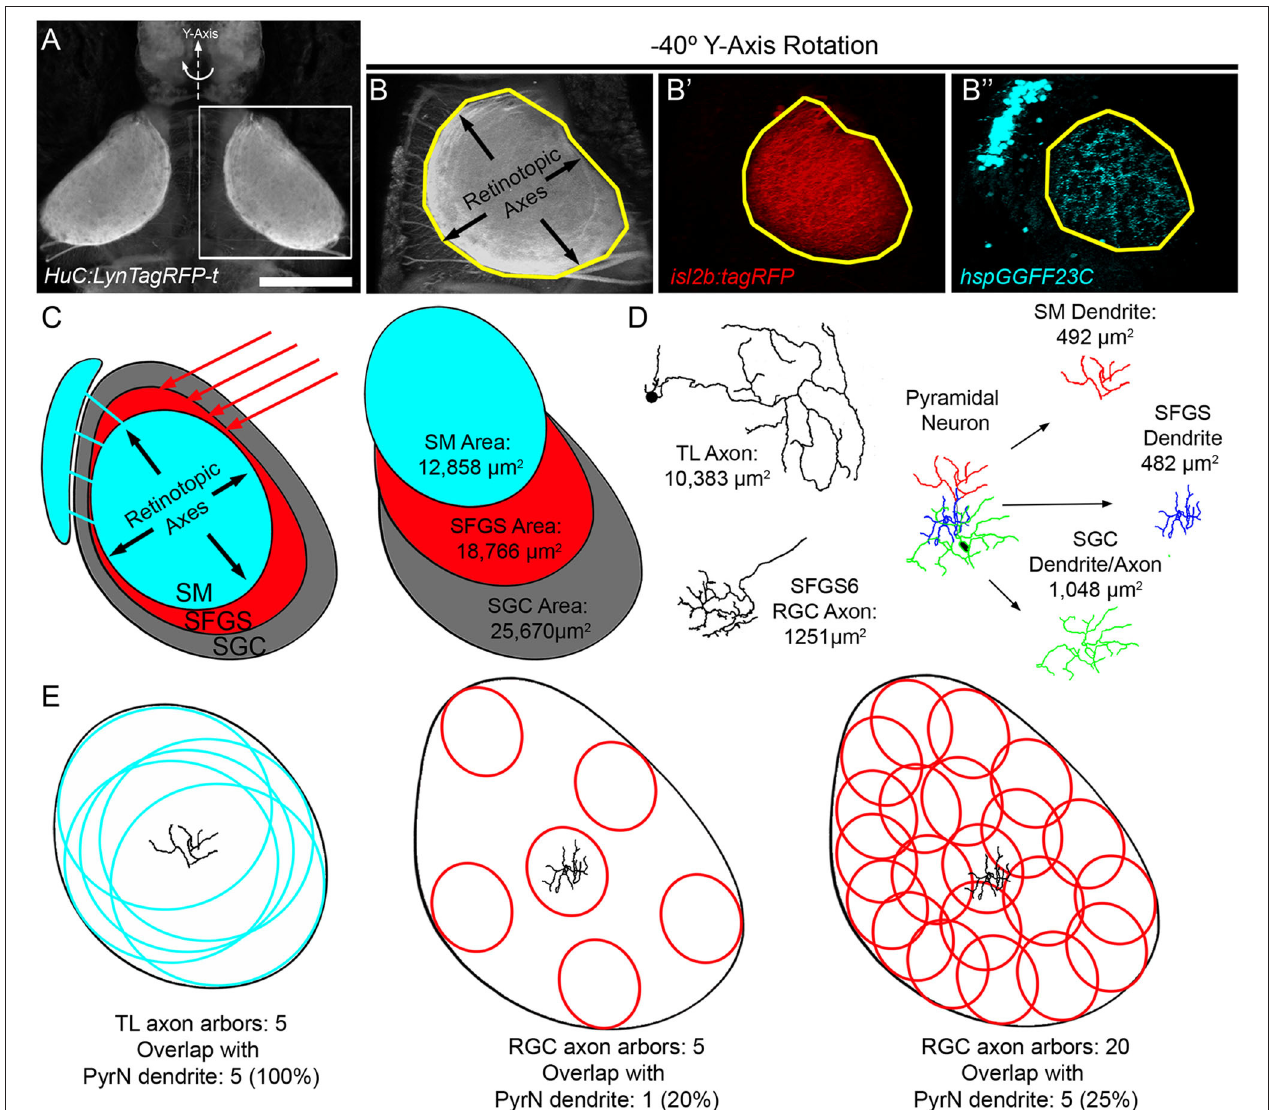
FIGURE 7 | Evidence for high degree of convergence from TL inputs to PyrNs. (A) Maximum projection image of fluorescence in a 7 dpf Tg( HuC:lynTagRFP-t) larva. (B) Maximum projection of boxed subregion in (A) rotated − 40 ◦ about the Y-axis, an orientation orthogonal to the tectal layers used for retinotopic area measurements. Maximum projection of equivalent subregions in a 7 dpf Tg(hspGGFF23C,uas:egfp,isl2b:TagRFP) larva rotated − 40 ◦ about the Y-axis. Yellow polygon drawn to assist in comparison of area differences between the three images. (C) Schematic at left summarizes tectal inputs from TL-recipient SM layer (cyan), retinorecipient layers (red), and total tectal neuropil area. Schematic at right summarizes area measurements for these different neuropil layers. (D) Skeletonized tracings and average retinotopic areas for TL axons, RGC axons, and PyrN neurite subregions. (E) Implications of size disparity between TL axon arbors and retinal axon arbors in tectum. TL axon arbor areas are depicted as cyan circles and RGC axon arbor areas are red ovals. Due to the large size of TL arbors, a PyrN dendrite at the center of SM has the potential to contact all TL inputs. Conversely, the small relative size of RGC axons innervating SFGS means that a PyrN dendrite at